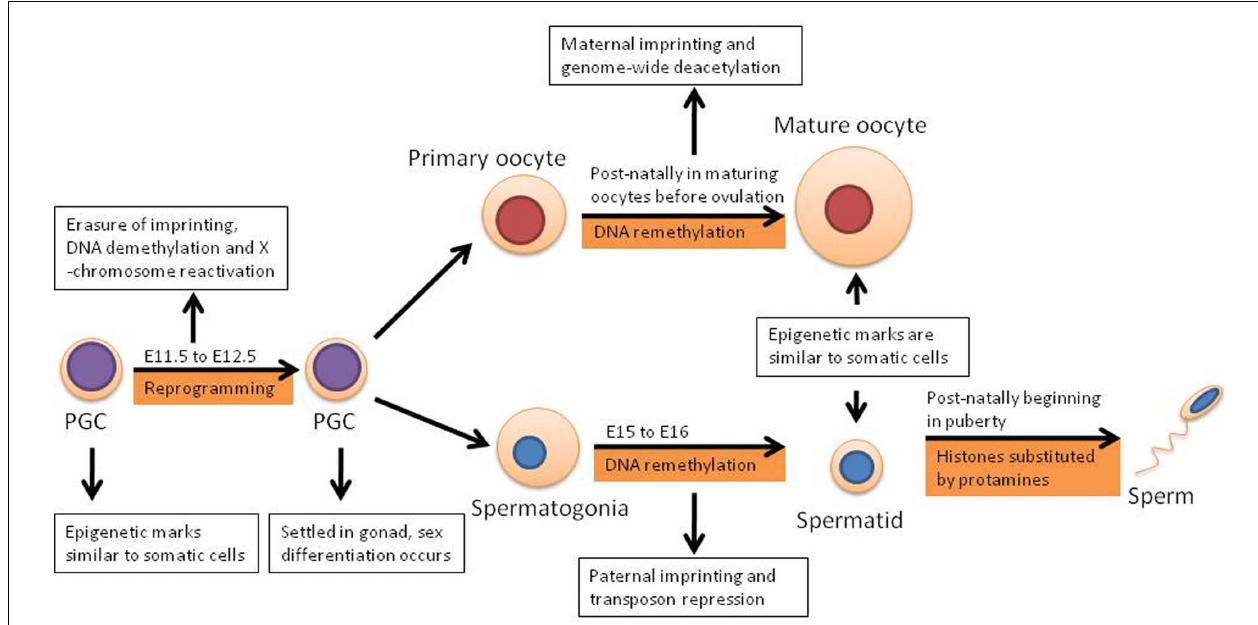
FIGURE 1 |The first round of epigenetic reprogramming occurs in the germline according to embryonic day (E) of mammals prior to the maturity of gametes and is distinct in males and